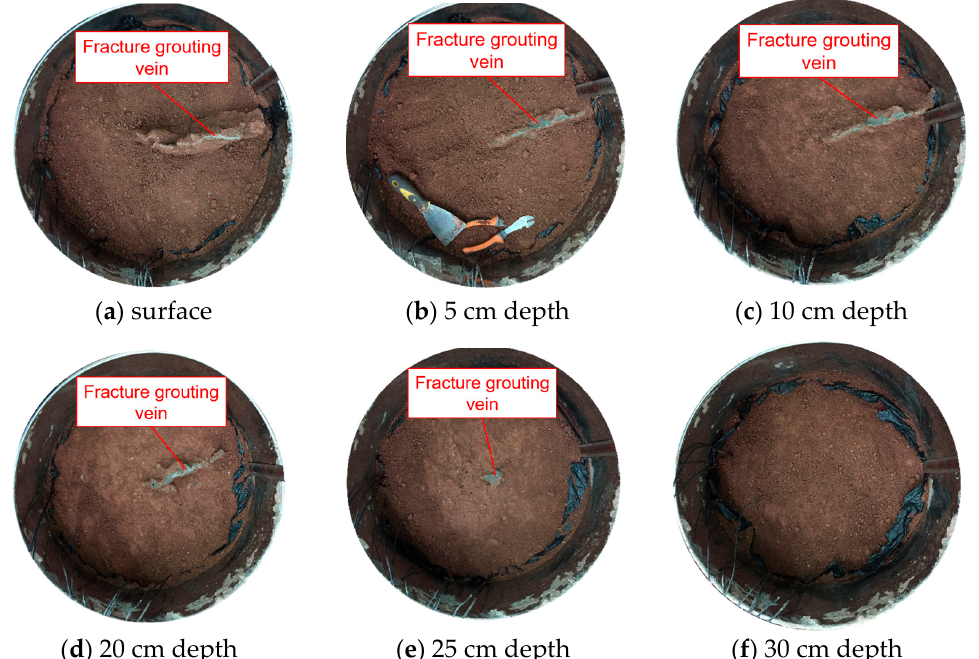
Figure 10. The concretion sections of Group #10.